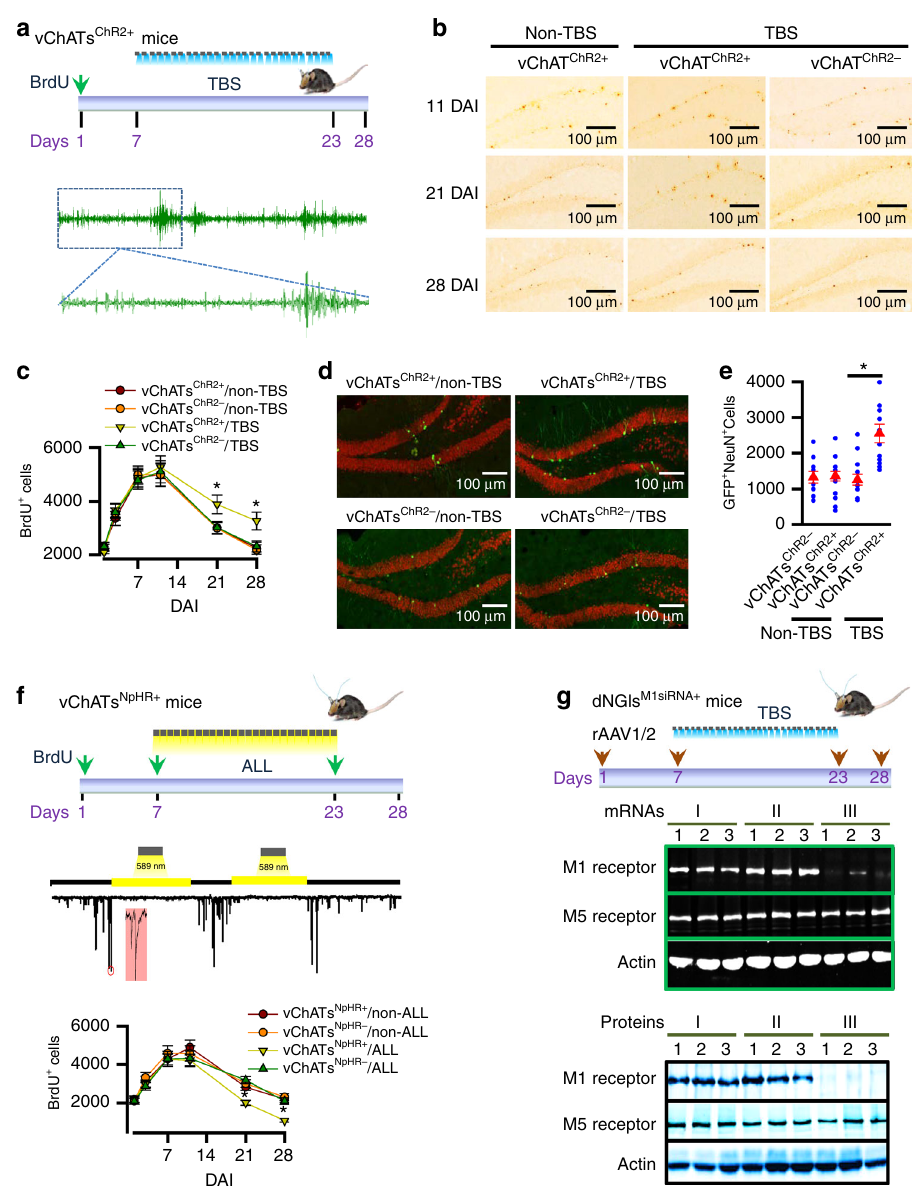
Fig. 3 Cholinergic transmission regulates the dNGIs survival. a Experimental schedule shows that mice at 120 ± 2 days old of age were administered with a single dose of BrdU. 7 days after the BrdU administration (DAI), TBS was applied for 16 consecutive days. BrdU staining was performed at 1, 3, 7, 11, 21, or 28DAI. Representative theta waves recorded from dDG region of vChATs ChR2+ mice in response to TBS. b , c Representative images b , and summarized numbers c , of BrdU + cells in the vChATs ChR2+ and vChATs ChR2 − mice treated without (non-TBS) or with TBS (mean ± SEM, n = 9 mice/group, * p < 0.01, two-way ANOVA with Bonferroni post-hoc test). d , e Representative images d and a plot e shows the actual (blue circles) and the averaged numbers (red triangles) of GFP + BrdU + cells in the vChATs ChR2+ and vChATs ChR2 − mice treated without (non-TBS) or with TBS (mean ± SEM, n = 11 mice/group, * p < 0.01, two-way ANOVA with Bonferroni post-hoc test). f Experimental schedule (top) for the BrdU administration and ALL application in both vChATs NpHR+ and vChATs NpHR − mice in vivo . BrdU staining was performed at 1, 3, 7, 11, 21, or 28DAI. Representative recordings (middle) indicate that the application of ALL (yellow light) blocked spontaneous excitatory currents in vChATs NpHR+ cells at a holding potential of − 60 mV. Bar graph (bottom) indicates the numbers of BrdU + cells in the vChATs NpHR+ and vChATs NpHR − mice treated without (non-ALL) or with ALL (ALL). BrdU labeling was performed at 1, 3, 7, 11, 21, or 28 DAI (mean ± SEM, n = 9 mice/group, * p < 0.01, two-way ANOVA with Bonferroni post-hoc test). g Experimental arrangements show the schedules of rAAV1/2 virus injection and BrdU administration. 7 days after the injection, TBS was applied for 16 consecutive days. Western blots and RT- PCR analysis were performed 5 days after the end of TBS. Representative images of mRNAs and proteins show 3 replicates (lanes 1, 2 and 3) in each condition; no virus (I), sM1siRNA (II) and M1siRNA virus injections (III). Similar results were seen in each of the four experiments optic fi ber (0.2 mm diameter) once per day (10 Hz for 15 min/ days ALL. Mice were euthanized at 1, 3, 7, 11, 21 or 28 DAI. The day) for 16 consecutive days (Fig. 3f). To determine the effects of numbers of BrdU + cells signi fi cantly decreased at both 21 and 28 DAI (Fig. 3f), whereas the numbers of proliferating glial cells, as vChATs inactivation on dNGIs survival, the vChATs NpHR+ mice identi fi ed by the expression of GFAP (GFAP + ), were unchanged were injected with a single dose (230 mg/kg body weight) of in the vChATs NpHR+ mice (Supplementary Fig. 5) compared with BrdU. 7 days after the injection (DAI), mice were treated with 16- NATURE COMMUNICATIONS | 8: